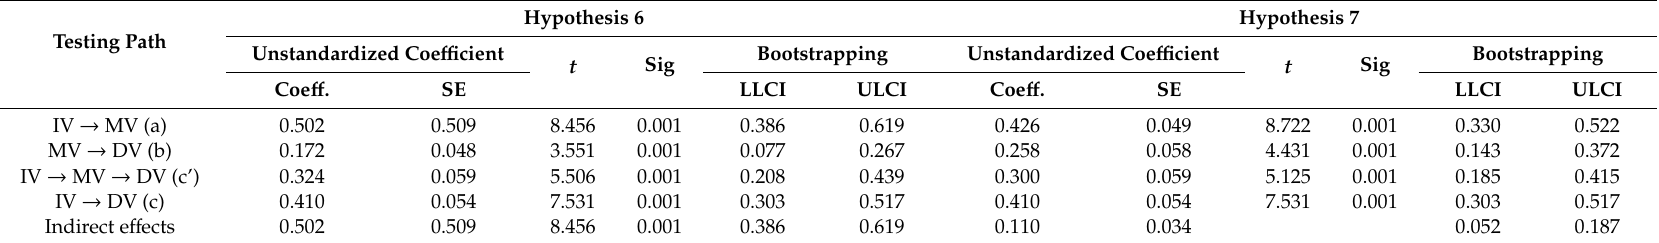
Table 6. Coe ffi cients for mediating e ff